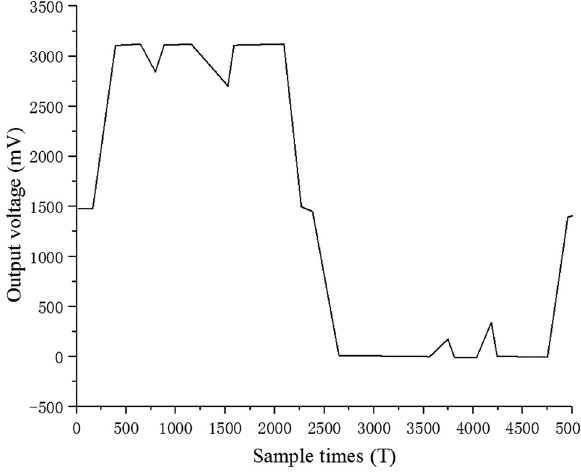
Figure 6: Robot turning and